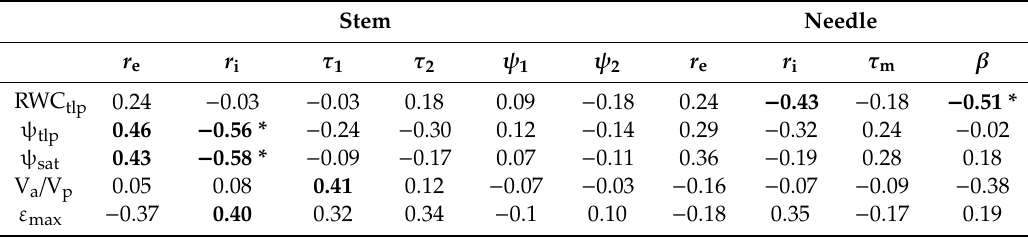
Table 2. Pearson correlation coe ffi cients between the electrical impedance spectroscopy parameters and pressure–volume curves parameters at week 4 after the post-planting growing period. Asterisks indicate a significant correlation coe ffi cient p < 0.05. Boldface indicates a significant correlation coe ffi cient 0.05 < p < 0.1. RWC tlp : relative water content of the initial plasmolysis; ψ tlp : osmotic potential at